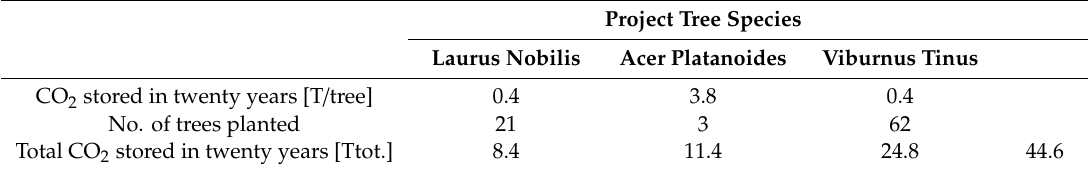
Table 7. Calculation of the total CO 2 abatement obtained through forestation Project Tree Species Laurus Nobilis Acer Platanoides Viburnus